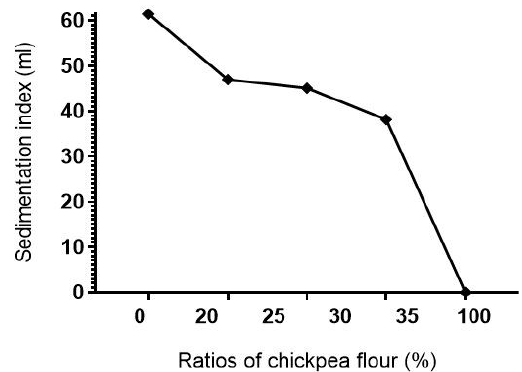
Figure 3. Gluten strength variation of whole durum wheat flour, whole chickpea flour, and their blends.